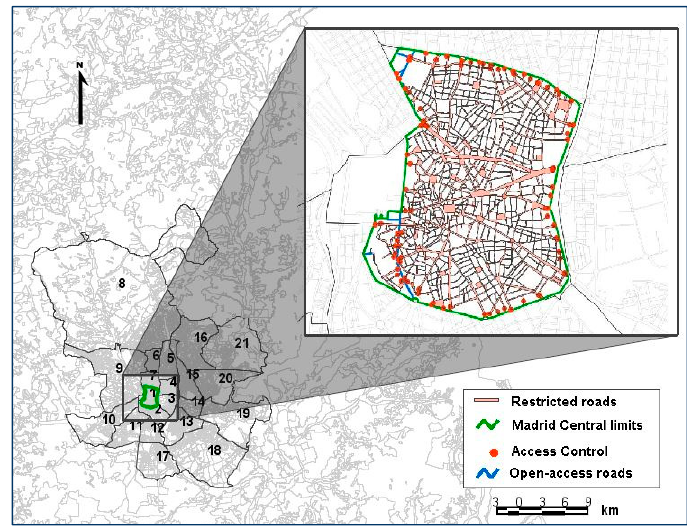
Figure 4. Residential priority area (RPA) or low emission zone (LEZ) in the downtown district. Source: Own elaboration, based on the data drawn from the Geoportal of the city council of madrid